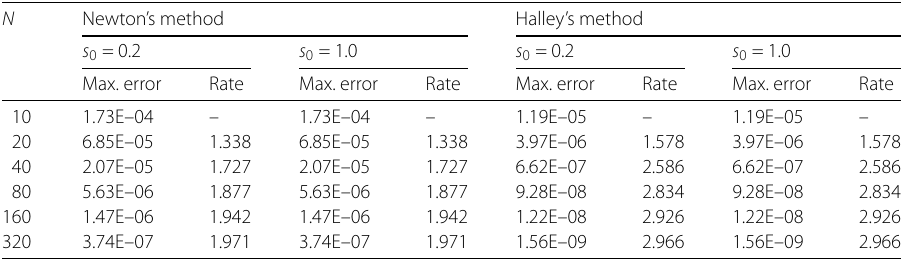
Table 8 Pointwise absolute errors in the maximum norm and computed rates of convergence versus the number of sub-intervals N in Example 4.3 as we set α 1 = 0.4, α 2 = 1.7, m =